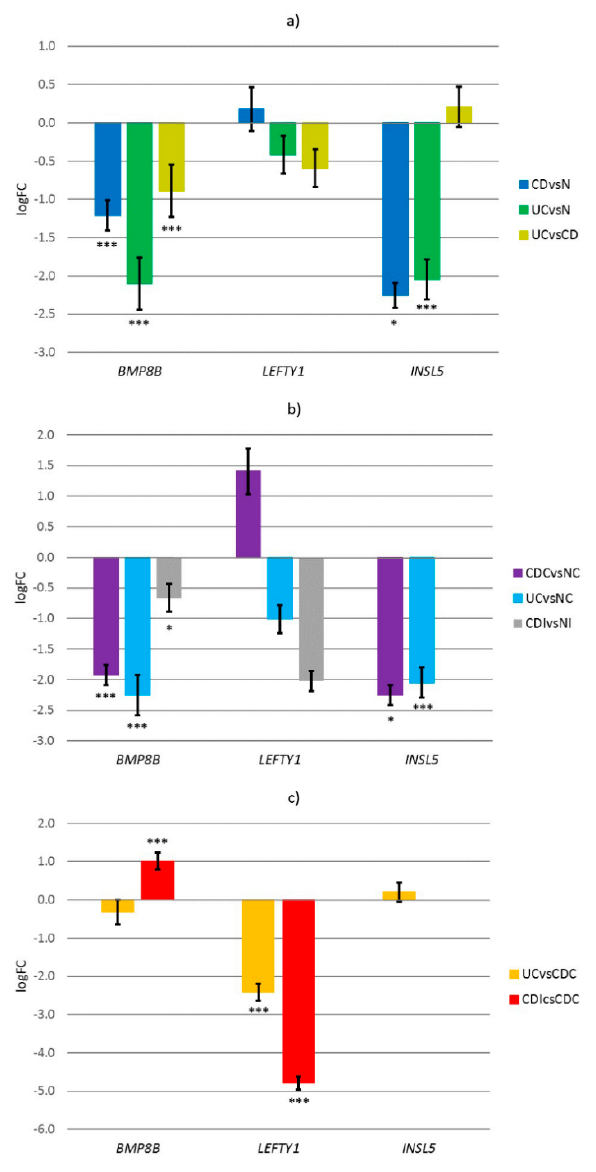
Figure 4. Expression of BMP8B , LEFTY1 and INSL5 of ( a ) Crohn’s disease compared to normal (blue), ulcerative colitis compared to normal (green) and ulcerative colitis compared to Crohn’s disease (yellow), ( b ) Crohn’s disease in colon compared to normal colon (violet), ulcerative colitis in colon compared to normal colon (light blue) and Crohn’s disease in ileum compared to normal ileum (gray), ( c ) ulcerative colitis in colon compared to Crohn’s disease in colon (orange), Crohn’s disease in ileum compared to Crohn’s disease in colon (red); lines represent error; *** p < 0.001, * p < 0.05; CD, Crohn’s disease; UC, ulcerative colitis; N, normal mucosa; CDC, Crohn’s disease in colon; UC, ulcerative colitis in colon; NC, normal colon mucosa; CDI, Crohn’s disease in ileum; NI, normal ileum mucosa. When dividing the samples based on location, either colon or ileum, further compar- isons were made, e.g., CD in colon (CDC) compared to normal colon (NC), UC in colon (UC) compared to NC and CD in ileum (CDI) compared to normal ileum (NI). In